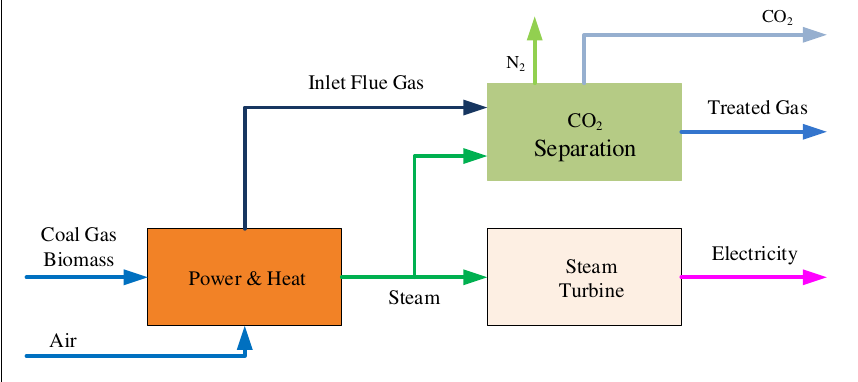
Figure 1. Schematic illustration of generation and CO 2 capture processes in power